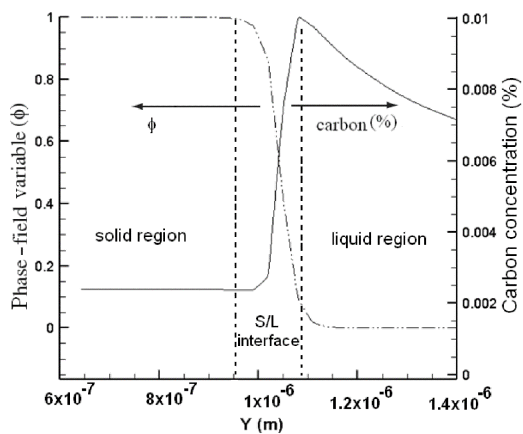
Figure 9. Carbon concentration by region: solid (ϕ= +1), liquid (ϕ= 0), and interface (0 <ϕ<